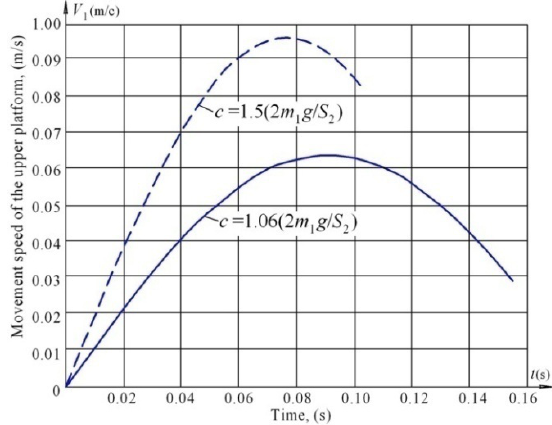
Figure 6. Influence of stiffness " c " of a mechanical spring on the speed of movement of the upper platform at m 1 =40